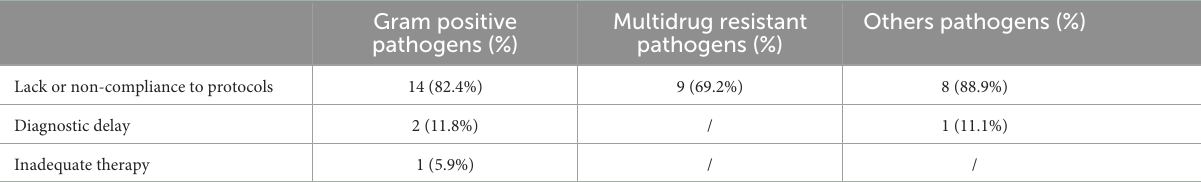
TABLE 3 Request for compensation 2020–2021 in